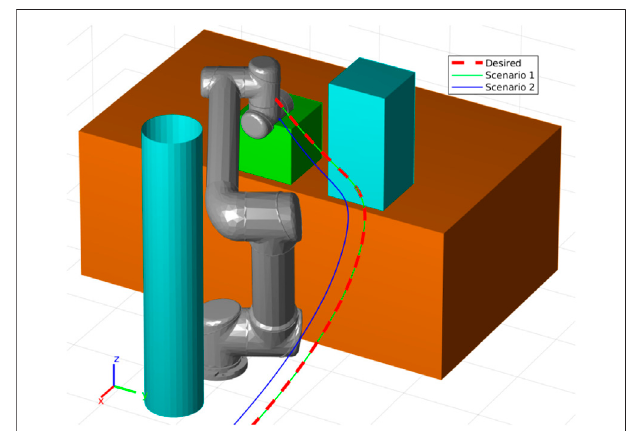
FIGURE 11 | The results of the CLF/CBF-based ProMP controller for a UR5 robot. Copyright 2021 IEEE. Reprinted, with permission, from Davoodi et al., 2021.